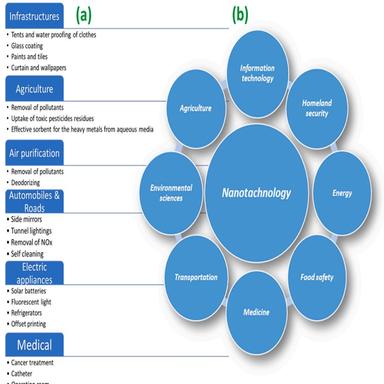
In the figure (a) discloses the potential applications of TiO2 NPs in different sectors of life and (b) elaborates the services of nanotechnology by using nanoparticles.